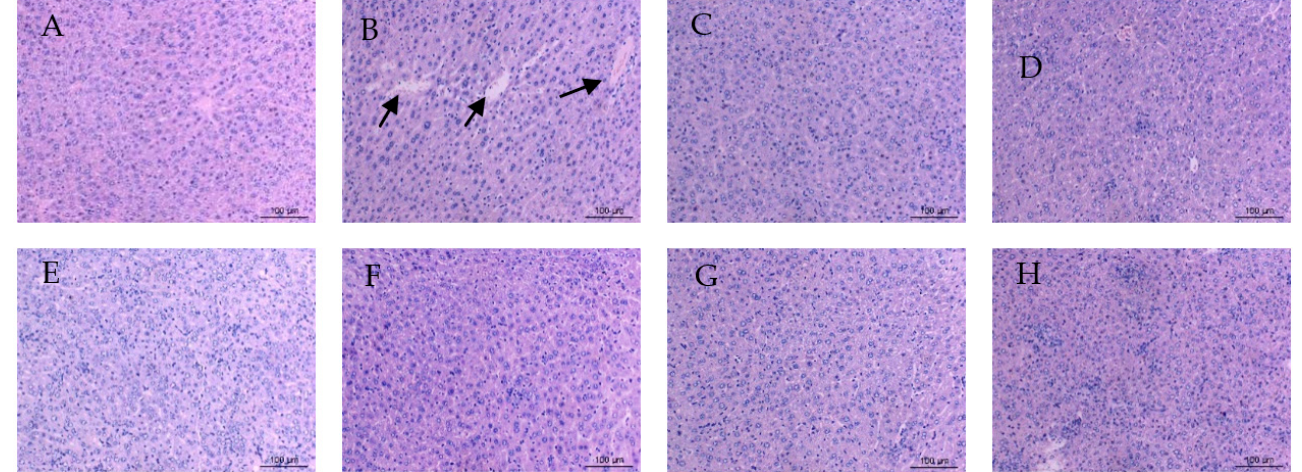
Figure 7. Representative H&E micrographs of dose–response liver histopathology (400×): ( A ) NC group; ( B ) MC group; ( C ) YC group; ( D – H ) ODP 1–5 group. NC: normal control group, MC: CdCl 2 - treated group, YC: positive-treated group. ODP1–5: ODP (50, 100, 200, 400, 600 mg/kg)-treated group.